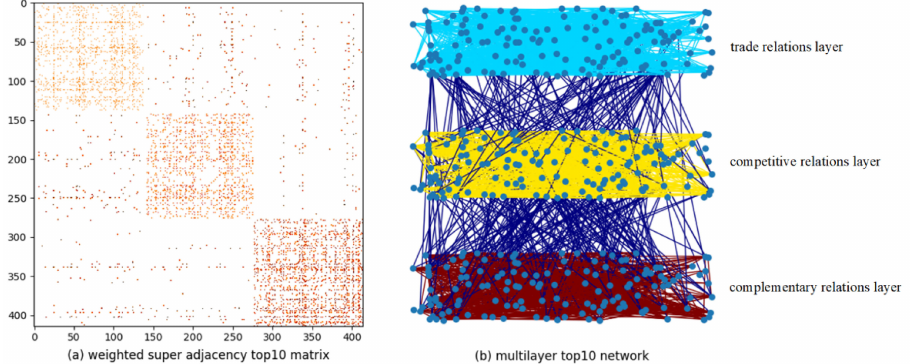
Figure 3. Category I agricultural multilayer top10